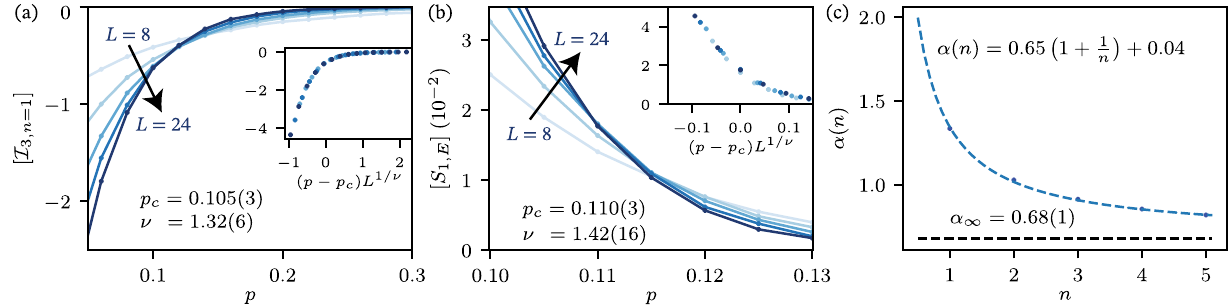
FIG. 2. Entanglement transition in qubit chains. (a) Data and collapse of the tripartite mutual information I 3 used to determine the ;n ¼ 1 0 . 105 ð 3 Þ , and the correlation length exponent, ν ¼ 1 . 32 ð 6 Þ . The error bars in p critical point of the entanglement transition, p and ν c ¼ c [28]; see Fig. 5. (b) Data and collapse of the are estimated using the region in parameter space near the minimum such that χ 2 < 1 . 3 χ 2 min used as an alternative method to determine the critical point of the entanglement entanglement transition order parameter ½ S 1 ;E (cid:2) 0 . 110 ð 3 Þ , and the correlation length exponent, ν ¼ 1 . 42 ð 16 Þ . The critical point and the exponent for ½ S transition, p 1 ;E (cid:2) are estimated c ¼ with a finite size scaling analysis as explained in Appendix D. (c) At the critical point, the bipartite entanglement entropy shows logarithmic scaling with the system size. The coefficient of the logarithm has strong R´enyi index dependence that can be described by a functional form α ð n Þ ¼ 0 . 65 ð 1 Þ½ 1 þ ð 1 =n Þ(cid:2) þ 0 . 04 ð 1 Þ . The error bars in α ð n Þ are obtained from the standard deviation of the fit parameters in α ð n Þ ∼ a ½ 1 þ ð 1 =n Þ(cid:2) þ b while the error in the data points themselves take into account the standard deviation of the fit p ; L Þ ∼ α ð n Þ ln L and the error in p parameters in S . This closely resembles the standard result for the ground state of a CFT, but has n ð c c an offset slightly larger than zero. Error bars on the data points are obtained from the error on the mean by computing the standard